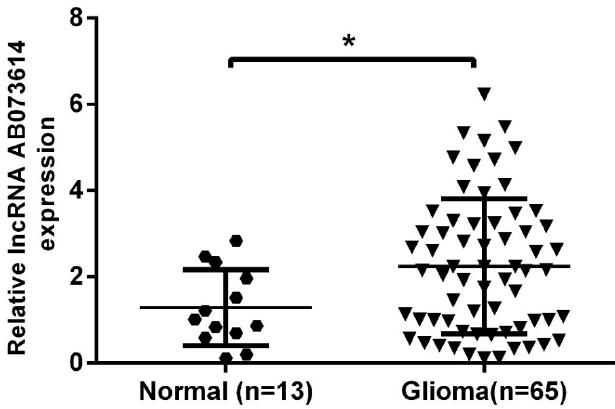
Figure 1. AB073614 was overexpressed in glioma tissues. The expression levels of AB073614 in 65 glioma and 13 normal brain tissues were detected by quantitative real-time polymerase chain reaction (qRT-PCR). AB073614 expression level was normalized to that of GAPDH (* p < 0.001).